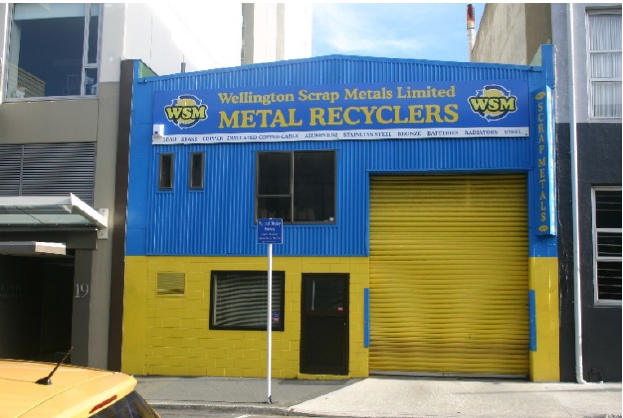
Figure 6. This building for a metal recycling business is typical of the older buildings in College Street. The new apartment building to its left creates a poor relationship between the two.